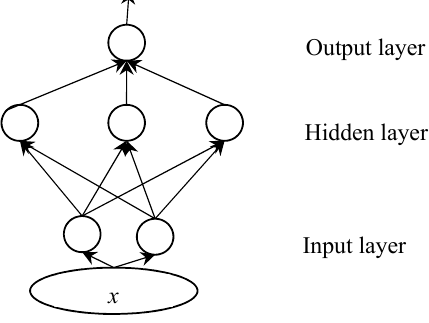
Figure A11. The architecture of Extreme Learning Machine.